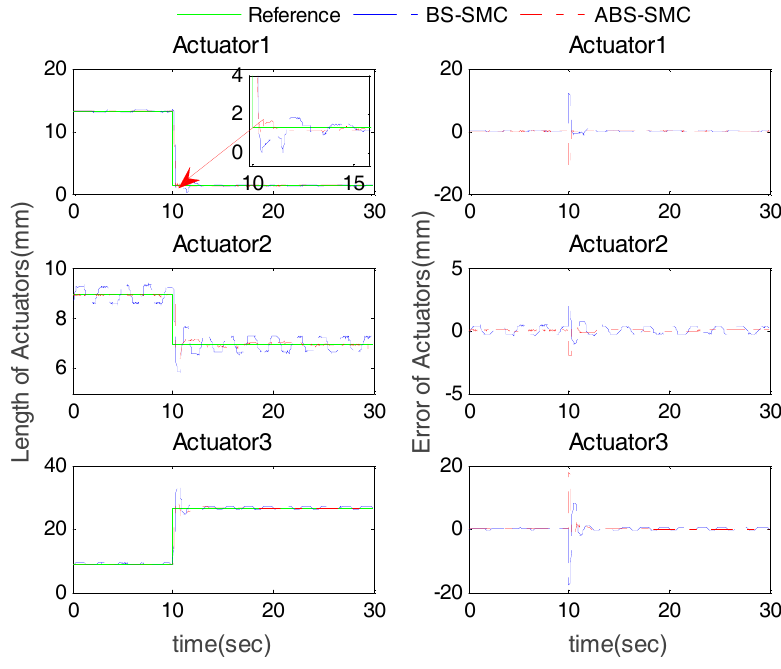
Figure 5. Actuator position tracking results and errors in step response experiment with robot controlled by BS-SMC and ABS-SMC respectively.